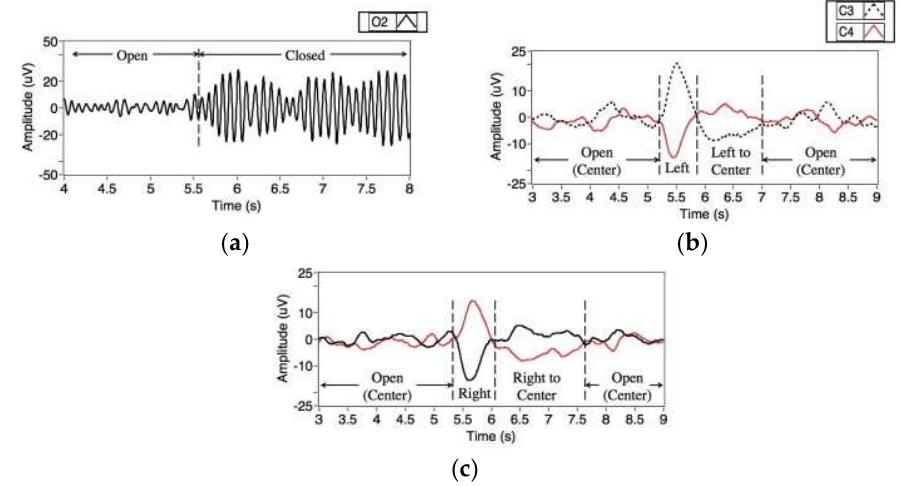
Figure 12. Eye- and eyelid-related signals observed at EEG channels. ( a ) Signal at O2 when closing and opening eyes, ( b ) Signals at C3 and C4 when moving eyes left, ( c ) Signals at C3 and C4 when moving eyes rights. Reprinted with permission [77].